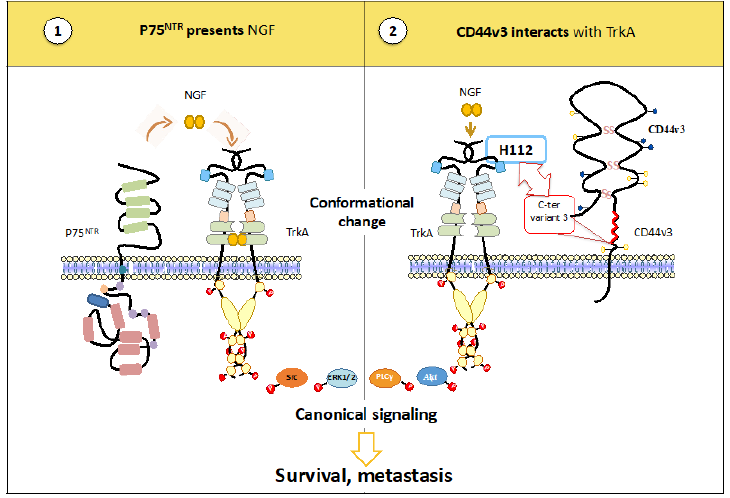
Figure 2. Comparison of the role of P75 NTR and CD44v3 in NGF binding to TrkA. P75 NTR presents NGF to TrkA ( 1 ) , whereas CD44v3 interacts with TrkA in the LRR1 NGF - binding region ( 2 ).